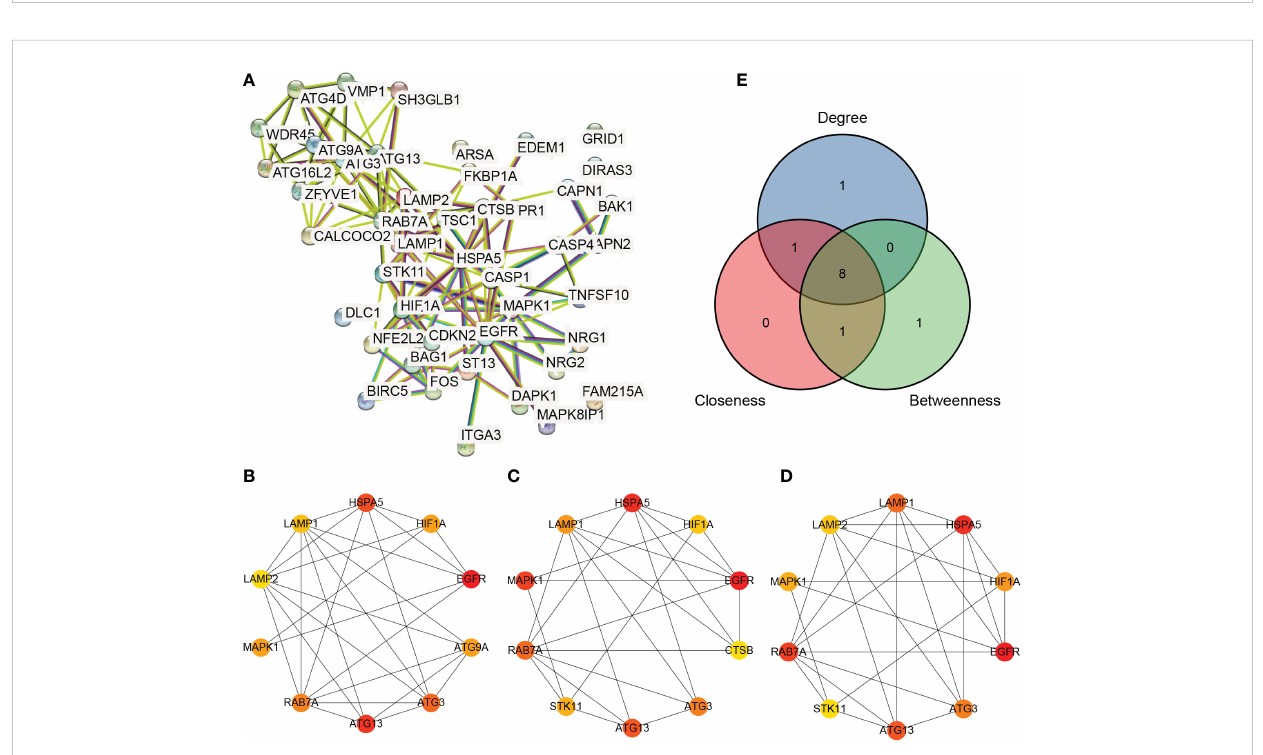
FIGURE 5 Protein – protein interaction network analysis. (A) Protein – protein interaction network of autophagy-related differentially expressed genes (B – D) : Hub genes calculated by the degree, betweenness, and closeness algorithms, respectively. (E) : Venn diagram of hub genes obtained using the three